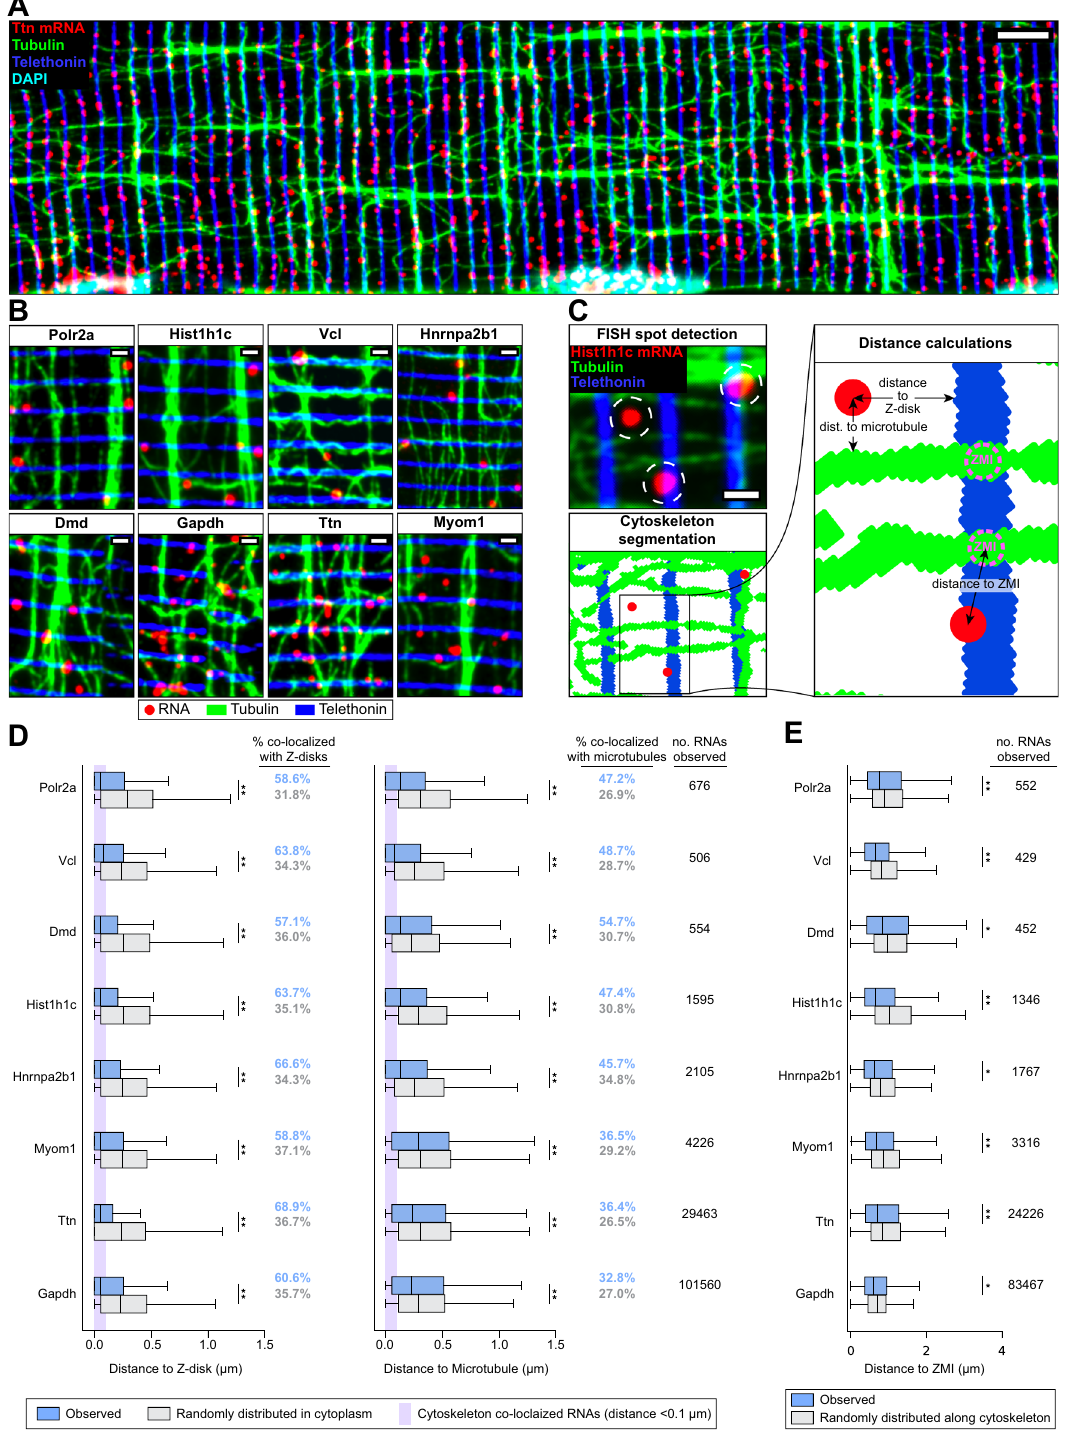
Fig. 2 RNAs co-localize with Z-disks and microtubules. A Representative image of IF/FISH co-labeling of Ttn RNAs (red), tubulin protein (microtubules, green), and telethonin protein (Z-disks, blue) in an isolated myo fi ber. Scale bar: 5 µ m. B Zoomed-in regions of IF/FISH co-labeled myo fi bers as in A for each RNA studied. Scale bars: 1 µ m. C Schematic describing the computational pipeline used to assess mRNA proximity to cytoskeleton from images of IF/ FISH co-labeled myo fi bers ( A ). D Distances from cytoplasmic spots (blue boxes) to Z-disks (left) and microtubules (right) compared to null distributions generated from randomly selected cytoplasmic coordinates (gray boxes). Data from n = 10 myo fi bers (Polr2a, Hist1h1c, Ttn, GFP) or n = 9 myo fi bers (Vcl, Dmd, Hnrnpa2b1, Myom1, Gapdh). Spots located within 2 pixels (~0.1 μ m) of either fi lament were considered “ cytoskeleton co-localized ” (purple shaded region, percentages). Box plots show minimum, fi rst quartile, median, third quartile, and maximum. * p < 0.03, ** p < 10 − 4 , Two-sided Mann – Whitney U test. E Distances from cytoskeleton-associated spots to ZMIs (blue boxes) compared to a null distribution generated from randomly selected coordinates along the cytoskeleton (gray boxes). Number of myo fi bers same as D . Box plots show minimum, fi rst quartile, median, third quartile, and maximum. * p < 0.03, ** p < 10 − 4 , Two-sided Mann – Whitney U